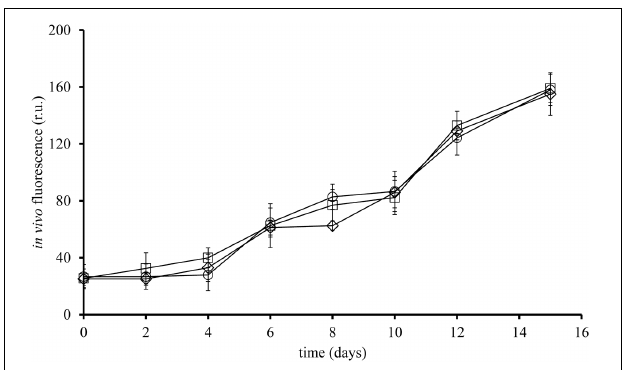
FIGURE 2 | Growth curve of L. polyedrum , axenic or in co-culture with a natural marine bacterial community. ( (cid:3) ) axenic, B-s; ( B-ns; ( ♦ ) non-axenic, B-ns. Each curve is the results of three culture replicates with the standard deviation indicated by vertical bars.